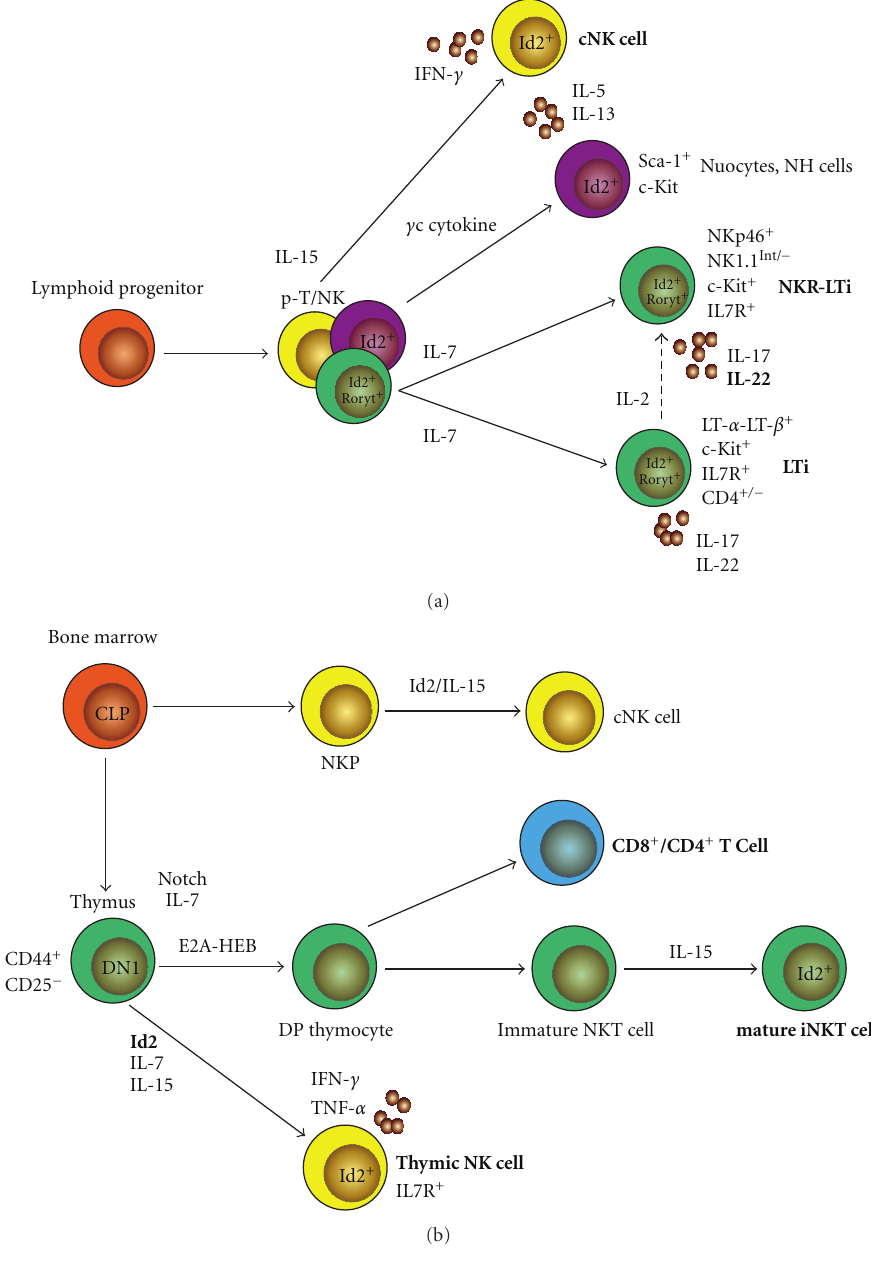
Figure 1: Regulation of NK, NKT, and innate lymphoid cells by Id2 during development. (a) Distinct subsets of lymphoid cells develop from hematopoietic cell precursors in the fetal liver in an Id2-dependent manner. Innate lymphoid cells can be divided into three main branches—(i) NK family, (ii) nuocytes/natural helper cells, and (iii) LTi/NKR-LTi cells that are dependent on Ror γ t. The NK cell lineage is characterised by its spontaneous cytotoxicity and dependence on IL-15 for development. They develop from a bipotent T/NK cell precursor (pT/NK). The second group of cells contain the nuocytes and natural helper (NH) cells that facilitate B-cell responses. Although these